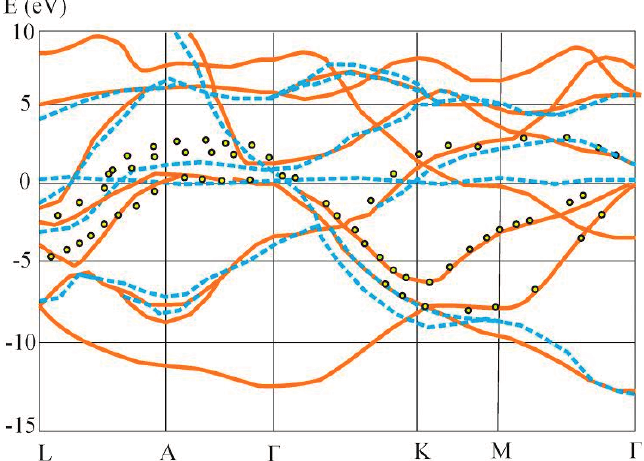
Figure 2. A typical fragment of the MgB 2 calculated band structure with addition of the Cr 2 O 3 (dotted line) and the superposition of the bicolor laser beams at 10.6 μ m at power density about 0.8 GW/cm 2 . For the convenience of the readers only BZ directions with maximal deviation from the perfect MgB 2 structure are